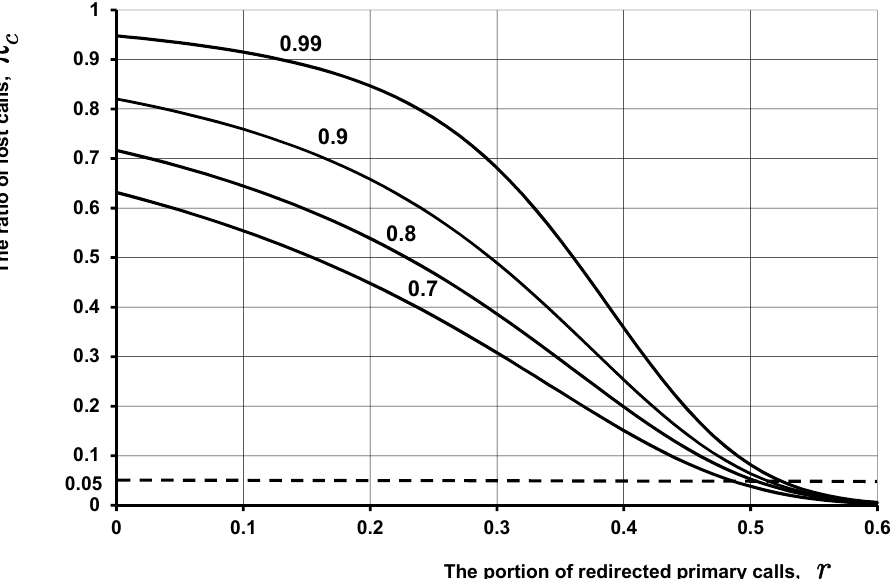
Figure 5. Dependence of π c on the portion of redirected primary calls r for different values of H 1 = H 2